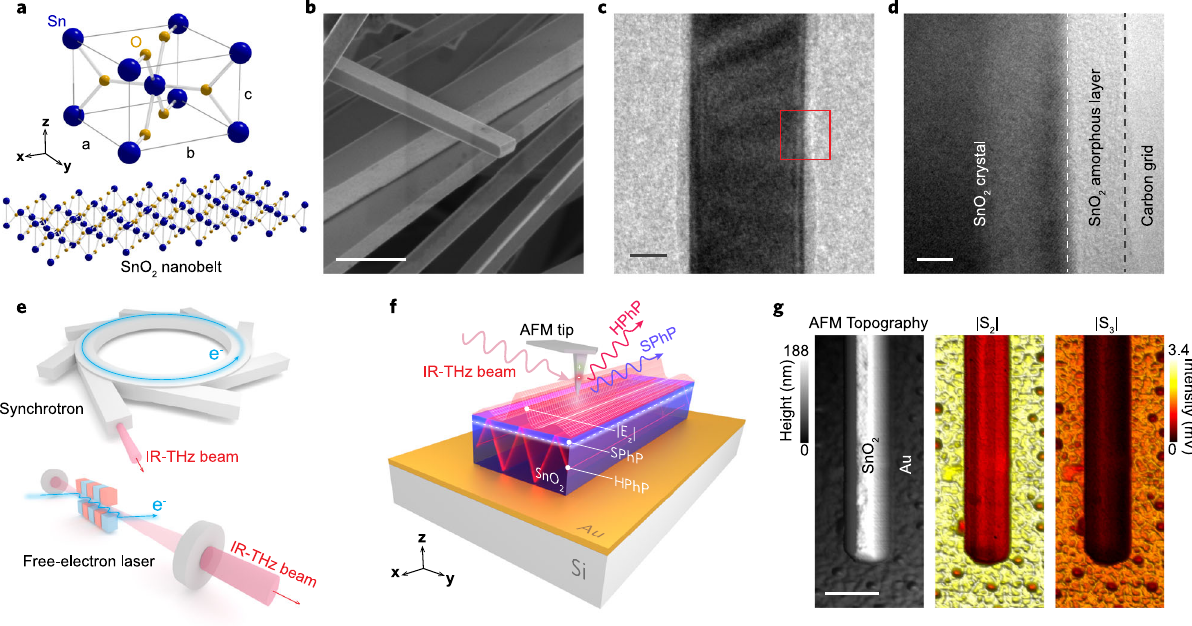
Fig. 1 Overview of SnO 2 -NBs morphology and spectral nano-imaging experiments. a Schematic of SnO 2 unit cell for tetragonal Rutile, and crystalline structure of the nanobelt. Blue and yellow spheres represent tin (Sn) and oxygen (O) atoms, respectively. b SEM image of SnO 2 -NBs. c TEM image of an isolated nanobelt covered by a thin amorphous layer in a carbon grid. d High-magni fi cation TEM image (red square in c ) highlighting the crystalline structure covered by a thin amorphous layer. e Accelerator-based IR-THz sources employed in the spectral nano-imaging experiments. f Experimental schematic showing the IR-THz beam illuminating a metallic AFM tip (nano-antenna) for the s-SNOM experiment. The highly con fi ned and vertically polarized electric fi elds ( E z ) at the tip apex launch surface (SPhPs) and volume (HPhPs) polaritons waves in the SnO 2 -NB. g Morphology (AFM topography) and broadband re fl ectivity (|S 2 | and |S 3 |) nanoscale images of an isolated SnO 2 -NB/Au simultaneously measured by SINS. Scale bars in b , c , d , and g represent 1 µ m, 50 nm, 5 nm, and 500 nm,